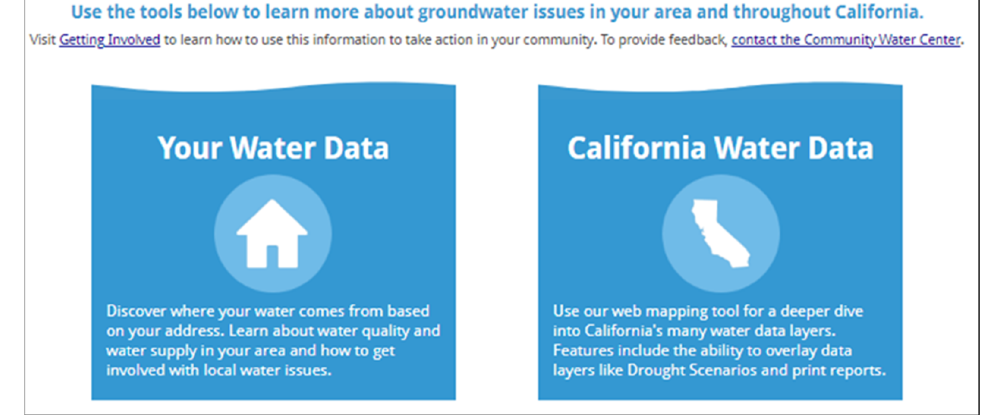
Figure 3. The Drinking Water Tool landing page displaying the two portals: Your Water Data and California Water Data.